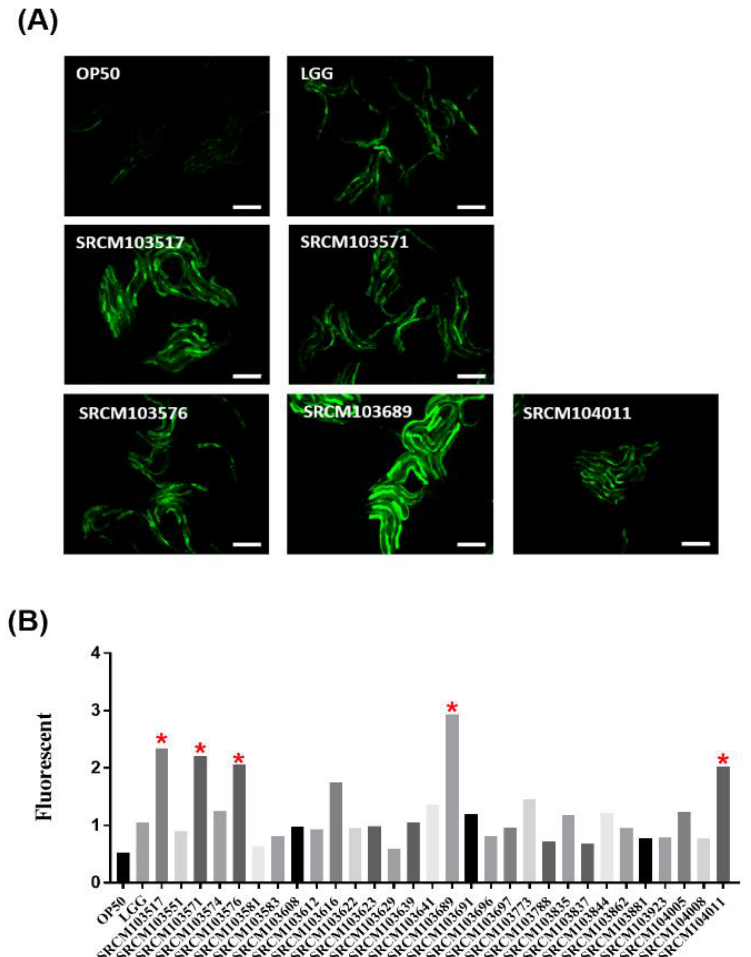
Figure 1. Induction of pmk-1 ::GFP exposed to candidate probiotics. ( A ) GFP visualization was assessed in the L4 stage of AY102 worms exposed to bacterial strains for 24 h. Animals integrated with the pmk-1 ::GFP transgene were visualized by fluorescence microscopy. The scale bar indicates 1 mm. ( B ) The degree of expression was measured using the ImageJ program and was then divided by the number of worms. Bacillus subtilis SRCM103689 showed the highest expression rate among the candidate strains. Red stars indicate five Bacillus subtilis strains showing high expression rate among the candidate strains.